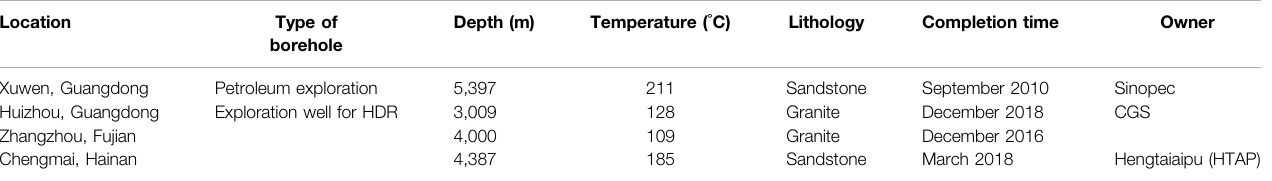
TABLE 1 | Information of deep wells from geothermal and petroleum in IRRSC.